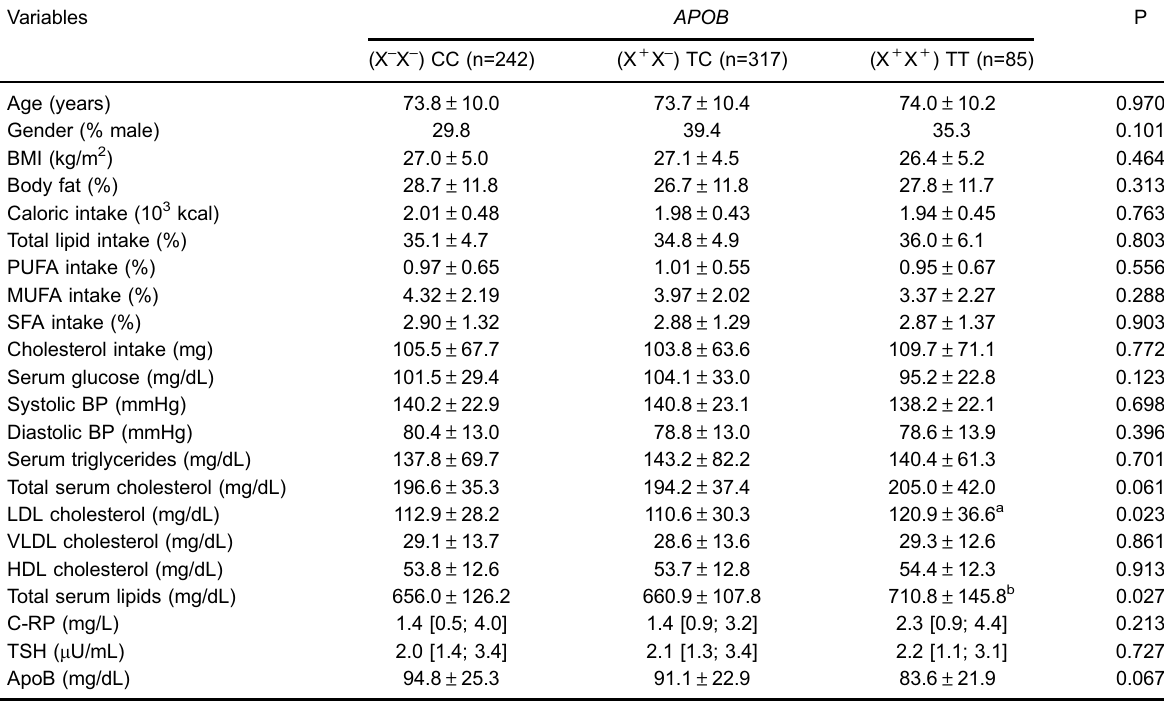
Table 1. Analysis of clinical and biochemical variables of the sample using MANOVA, according to genotypes of the APOB gene.